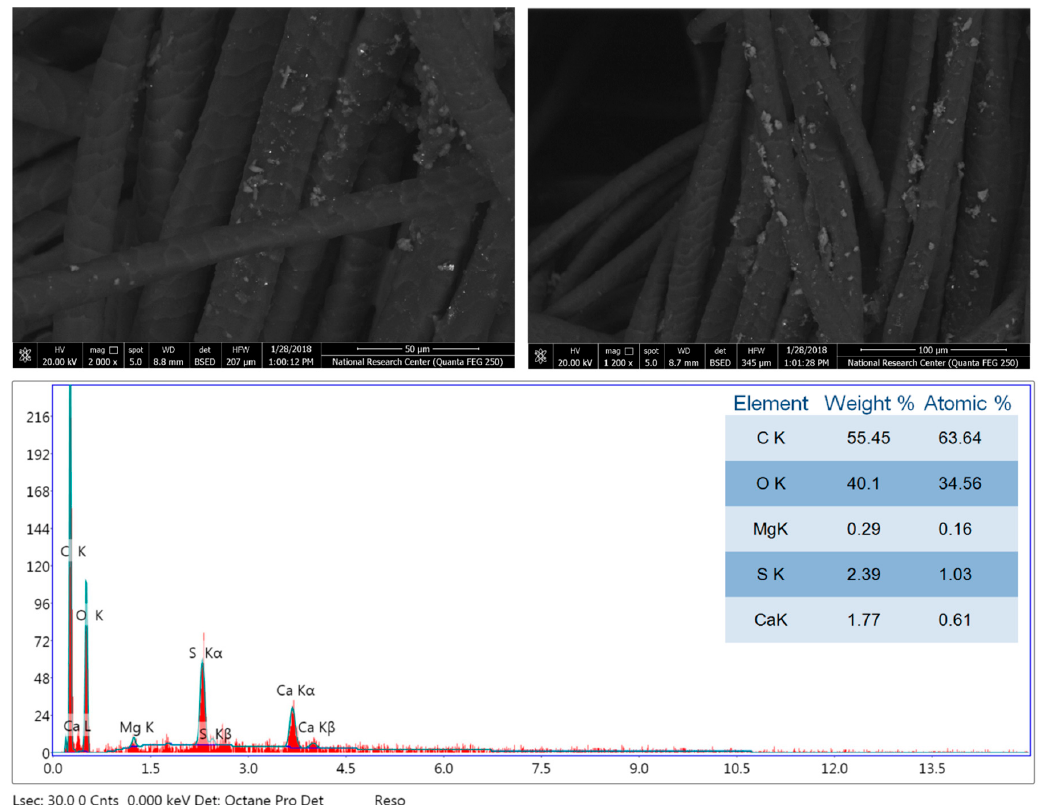
Figure 4. SEM images and EDX diagram of MgO nanoparticles incorporated onto a pre-treated wool fabric.